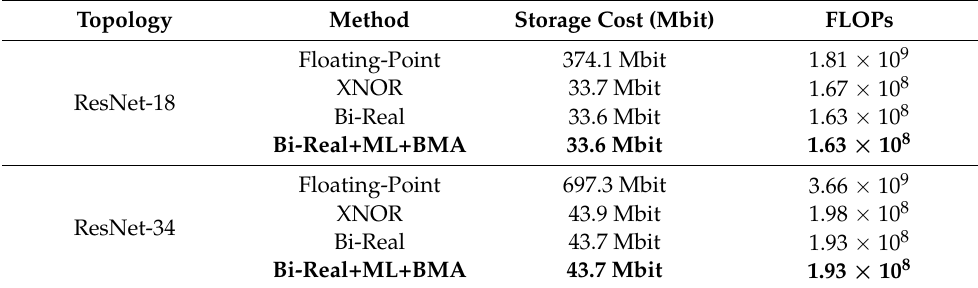
Table 6. Comparison of storage cost and calculation complexity upon ResNet18 and ResNet34. Our proposals are highlighted in